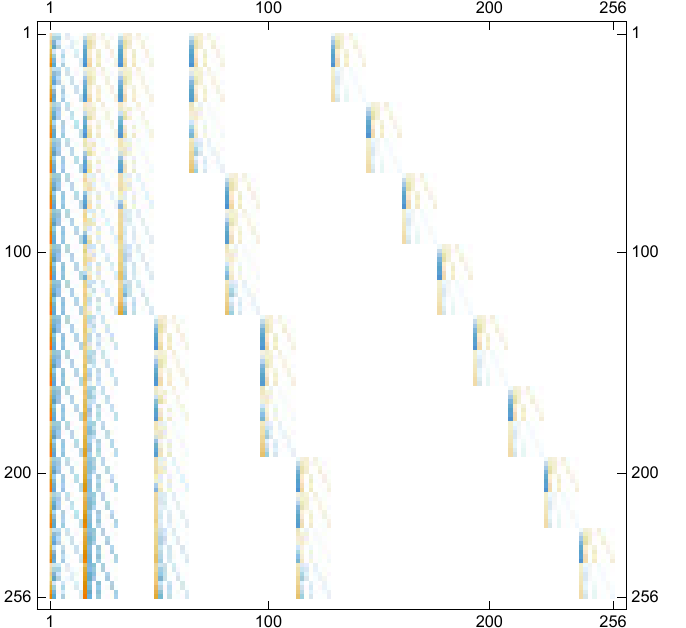
Figure 4. The visual representation of the matrix coefficient computed for Example 2 when M = 16, µ = 1, α = 19 /